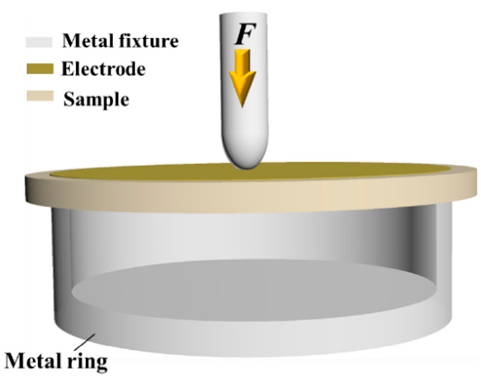
Figure 4. Schematic of point ‐ ring method used to apply strain gradient.